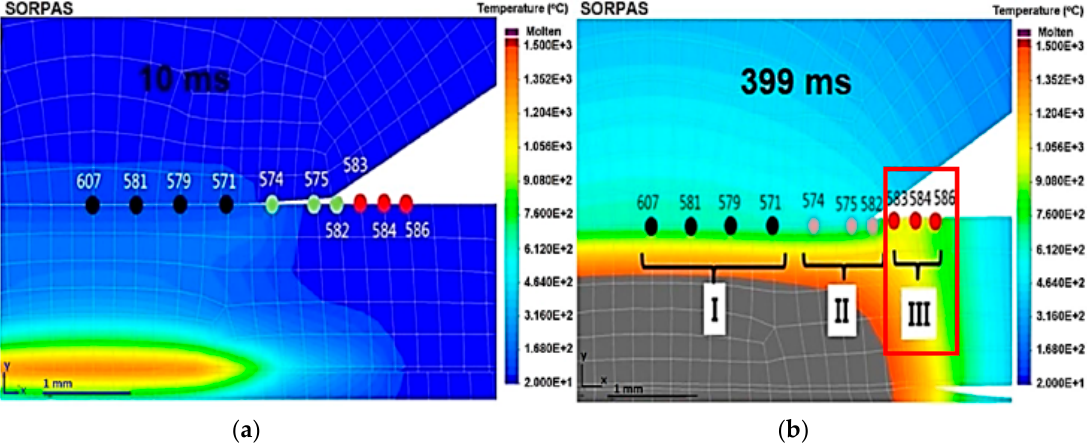
Figure 10. (a) An LME crack simulation of electrode-workpiece interaction. ( b ) Temperature profile and stress distribution across different regions. Node 583 is estimated to have the longest LME cracks because a high tensile stress and a high temperature of about 900 °C were maintained for 200–600 ms. Reprinted with permission from [36], Springer, 2018.